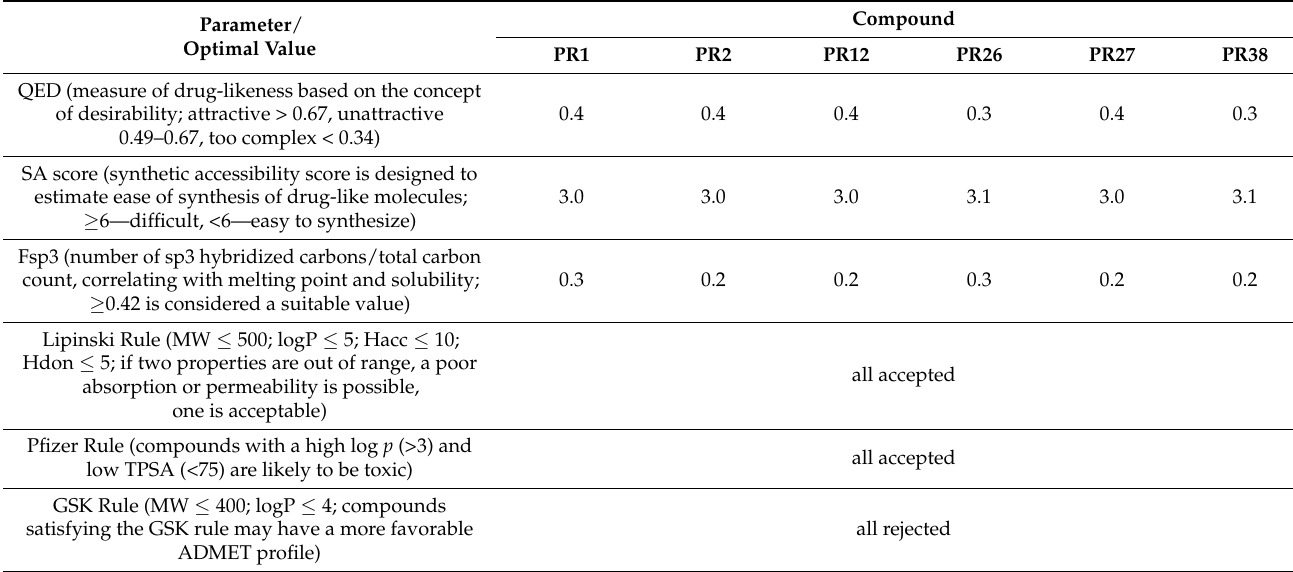
Table 3. Medicinal chemistry of studied